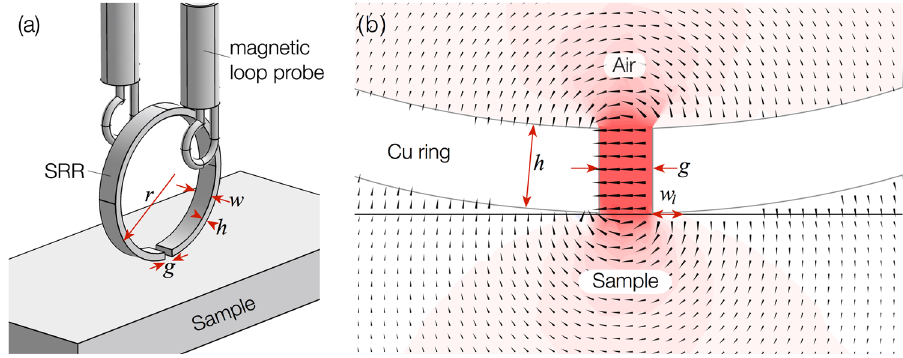
Figure 1. ( a ) Schematic of the experimental 3D arrangement of the SRR probe coupled between two magnetic loop probes and in touching contact with the surface of a material; and ( b ) the zoomed-in cross-section of the SRR in contact with a material with ε r = 2 − j · 0.02. The vectors and color contours represent the direction and strength of the induced electric field in the plane of the cross-section at the resonant frequency, according to full wave